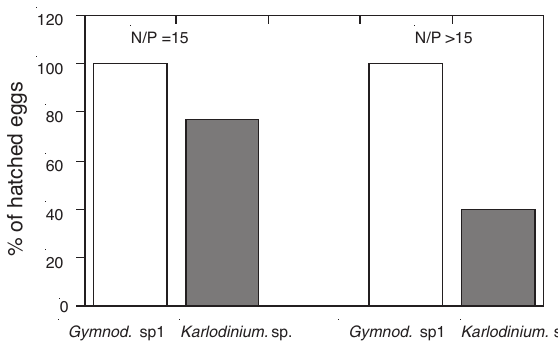
F IG . 4. – Percentage of hatched eggs of Acartia margalefi incubat- ed with 2000 cells ml -1 of Karlodinium sp. (CSIC1) and Gymnodinium sp1 grown under N/P balanced (NP = 15) and P-limitation conditions (N/P >